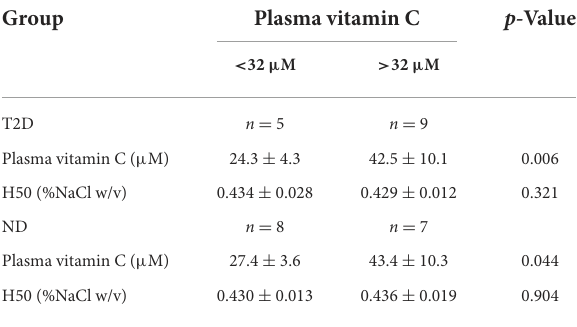
TABLE 2 Comparison of biochemical parameters for participant groups as a function of vitamin C status. Group Plasma vitamin C p- Value < 32 µ